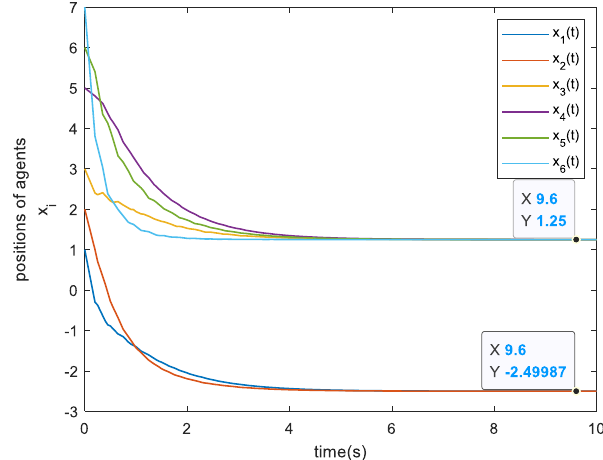
Figure 2. The states of agents.